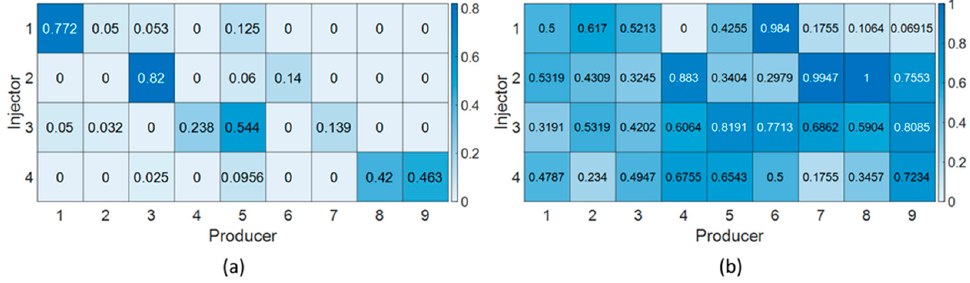
Figure 6. The disequilibrium factors of the three-channel model. ( a ): The results obtained via IRNN; ( b ) The results obtained via MLP.